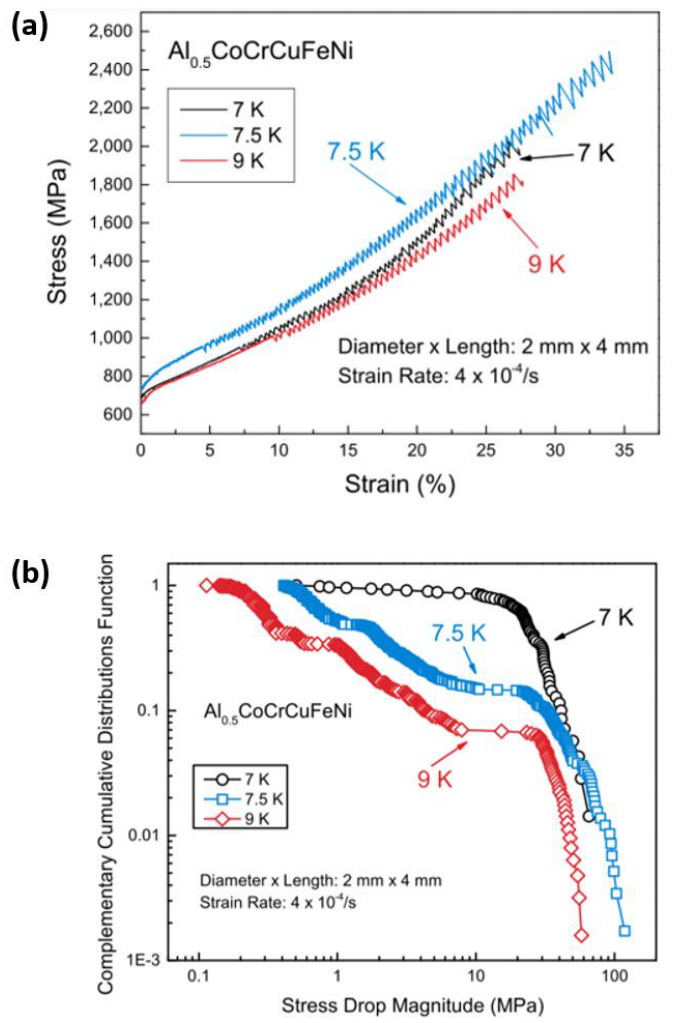
Figure 21. ( a ) Compressive stress–strain curves for the Al 0.5 CoCrCuFeNi HEA at temperatures ranging from 7 to 9 K, at a strain rate of 4 × 10 − 4 s − 1 , and ( b ) the CCDF for the Al 0.5 CoCrCuFeNi HEA (reproduced from Reference [167] with